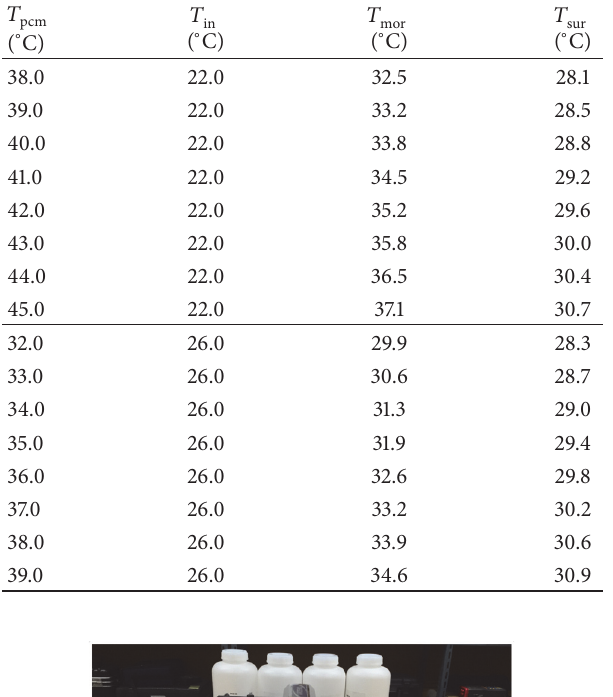
Table 1: Calculations of indoor underfloor surface and PCM temperatures.